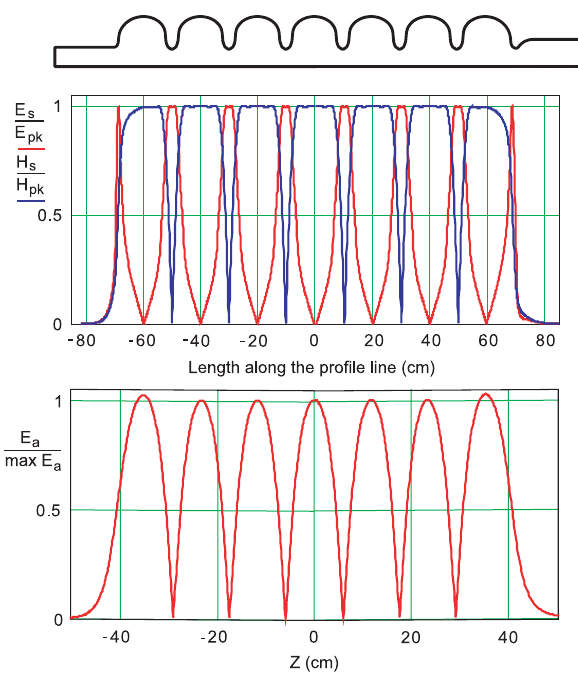
cavity.FIG. 17. (Color) Geometry of the cavity combined from the two half-cavities: shown in Fig. 6 (mirrored about the left end plane) and 10, the fields along the profile line, and the electric field on